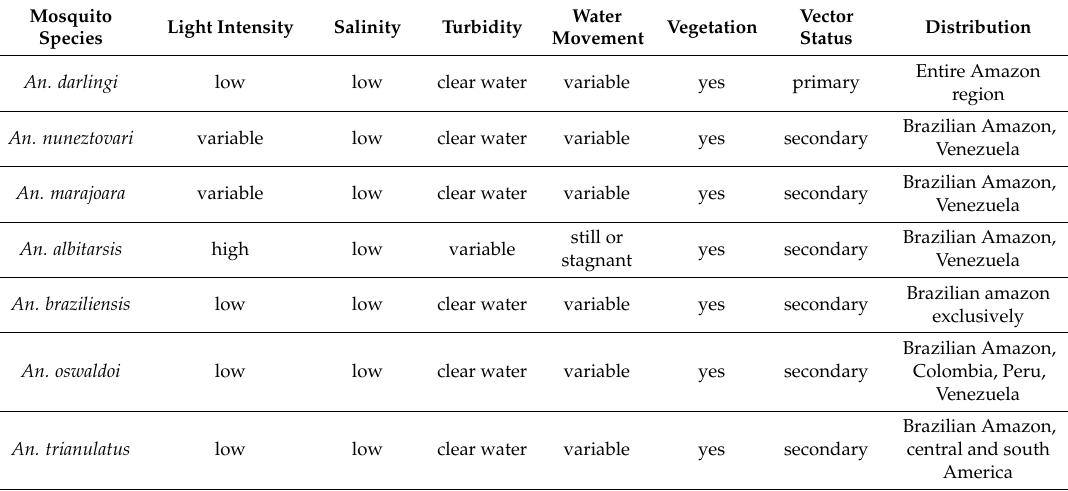
Table 1. Main characteristics of breeding sites for primary and secondary species of Anopheles mosquitoes transmitting malaria in the Americas, including the Amazon (from [12]).